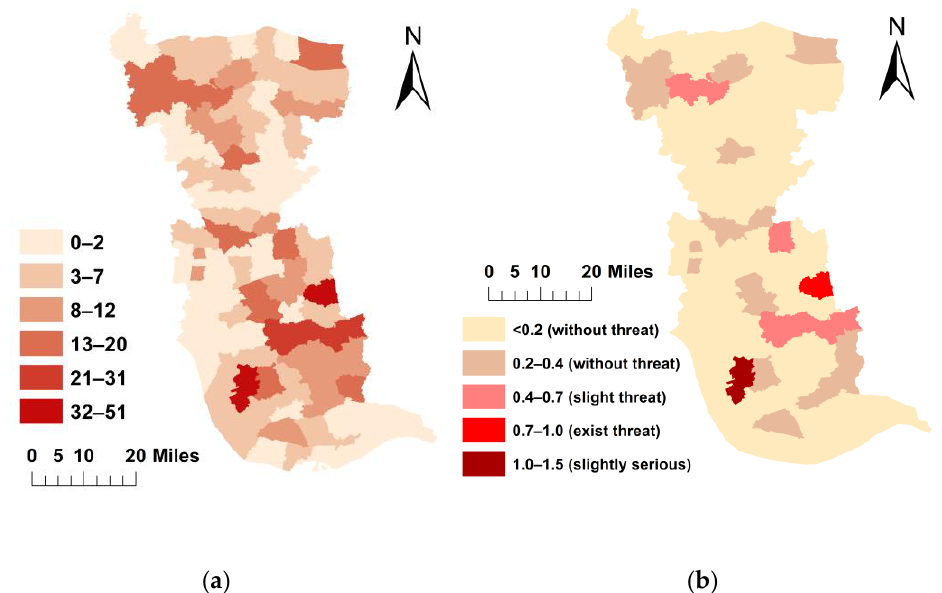
Figure 3. Assessment of land carrying capacity based on contaminate load at small scale: ( a ) manure pollution load (t/hm 2 ); ( b ) carrying risk level of arable land.